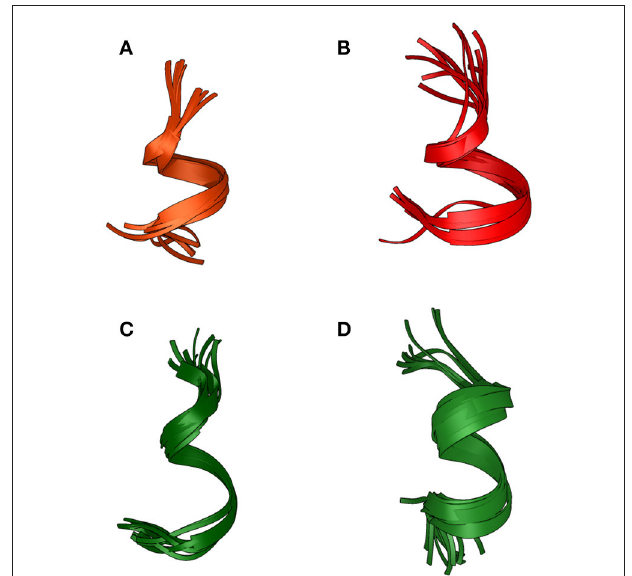
FIGURE 3 | Backbone overlay of the 10 lowest energy NMR-conformations of Pepcan-9 (A) and Pepcan-12 (B) in 50/50 v/v HFIP/NaP, pH 3.0,